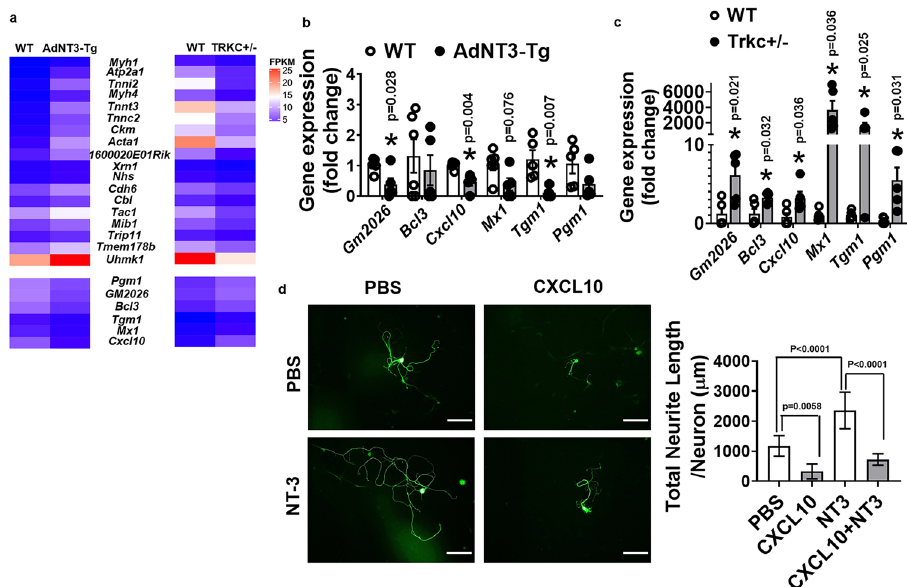
Fig. 7 RNA-seq analysis of sympathetic ganglia from AdNT3-Tg and TRKC + / − mice after 1-day cold challenge. a Heatmap of the expression of genes regulated in the opposite direction in sympathetic ganglia from thoracic T1 to T4 levels of AdNT3-Tg and TRKC + / − mice after 1-day cold challenge. T1 – T4 sympathetic ganglia from six mice each group was pooled for RNA-seq analysis. b , c Real-time RT-PCR validation of the genes that are downregulated in sympathetic ganglia of AdNT3-Tg mice ( b , n = 5 for WT (except for Tgm1 and Pgm1, where n = 4); n = 5 for AdNT3-Tg. * Indicates statistical signi fi cance between WT and AdNT3-Tg with unpaired two-tailed t test), but are upregulated in sympathetic ganglia of TRKC + / − mice ( c , n = 5/group, * indicates statistical signi fi cance between WT and TRKC + / − with unpaired two-tailed t test) after 1-day cold exposure. d Measurement of neurite growth in sympathetic neurons treated with NT-3 (100 ng/ml) in the presence or absence of CXCL10 (100 ng/ml) (PBS n = 50, CXCL10 n = 43, NT-3 n = 47, CXCL10 + NT-3 n = 40. Statistical signi fi cance was analyzed by two-way ANOVA; with or without CXCL10 treatment, F (1, 210) = 95.47 P < 0.0001; with or without NT-3 treatment, F (1, 210) = 35.62 P < 0.0001. * Indicates statistical signi fi cance as shown in ( d ) with Turkey ’ s multiple comparisons test. Scale bar = 100 µ m). Neurons from sympathetic ganglia at thoracic T1 – T4 levels were isolated and used in this experiment. All data are expressed as mean ± (Fig. 8h) and had increased fat mass in iBAT, iWAT, and eWAT (Fig. 8i) with larger adipocytes sizes (Supplementary Fig. 20a)